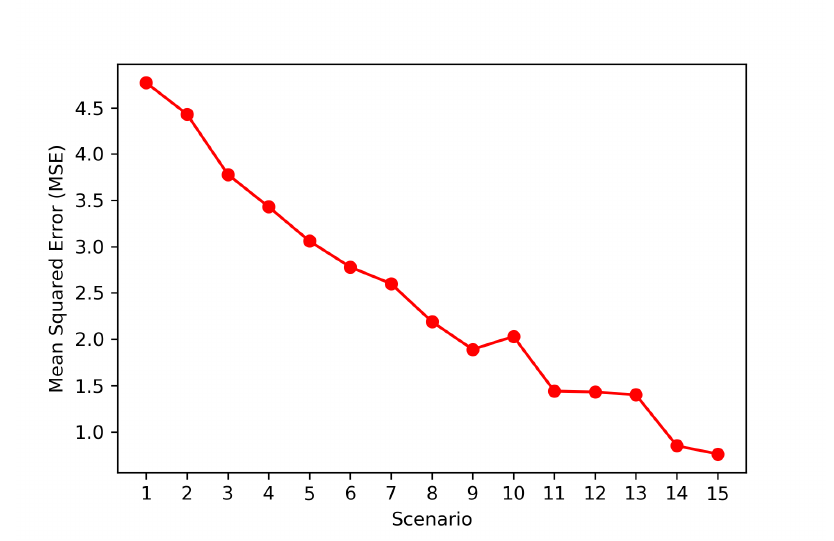
Figure 10. Mean Squared Error of the coestimation in each scenario.